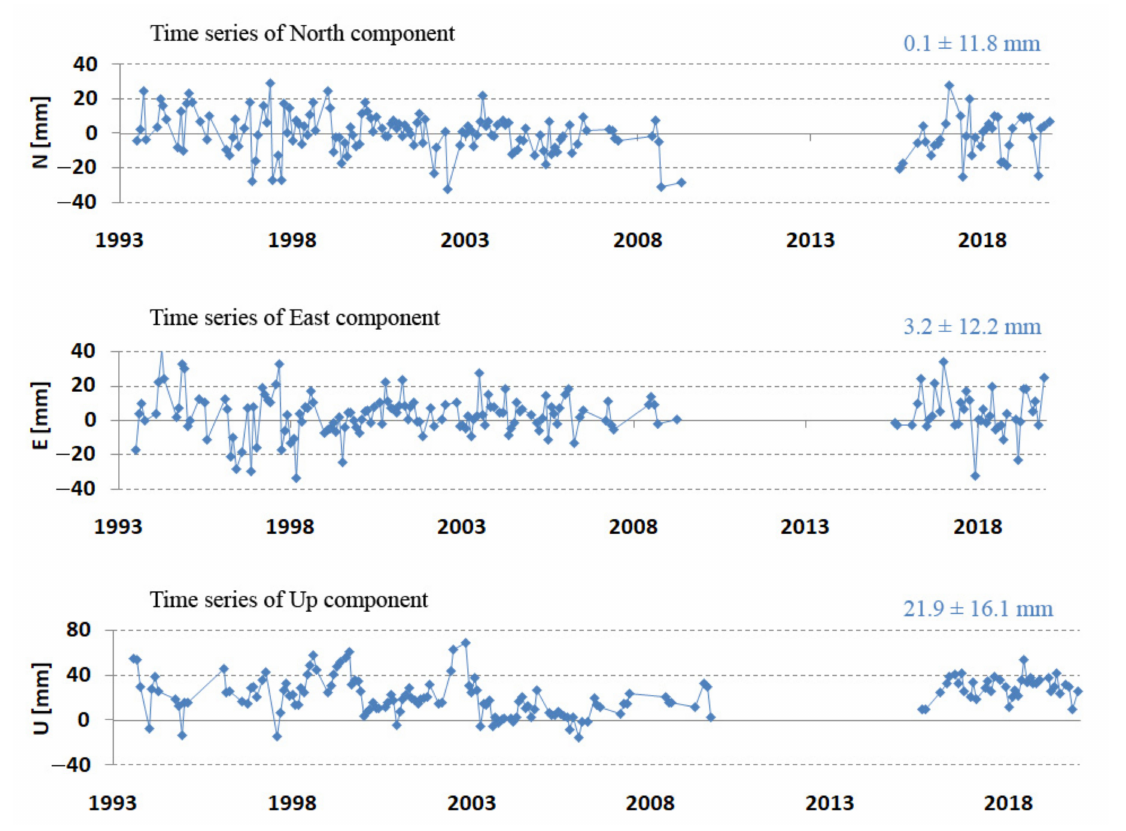
Figure 8. Borowiec SLR station—de-trended for epoch 2010.0 topocentric coordinates N, E, U (mm) in 1993–2019.